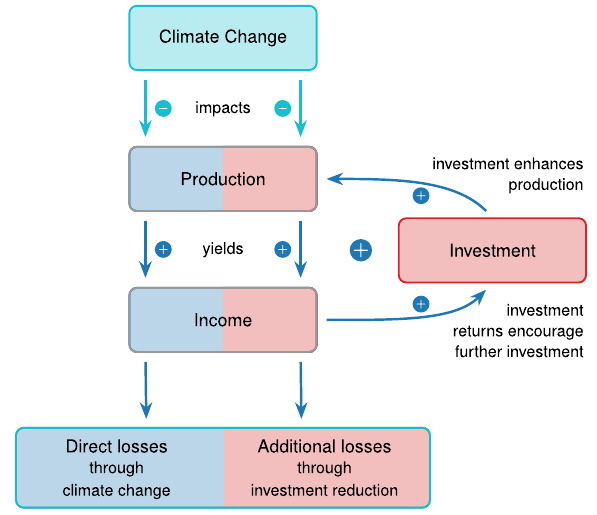
Fig. 1 Illustration of the investment effect. Climate change reduces productivity, which translates into direct income losses (blue boxes). The prospect of reduced investment returns in the future renders investment less attractive. Accordingly, economically optimal investment is reduced and less production enhancing capital is accumulated. As a result, economic growth slows down and yields a future of persistently lowered income. This effect arising through reduced investment incentives is here referred to as the additional investment effect (depicted by red